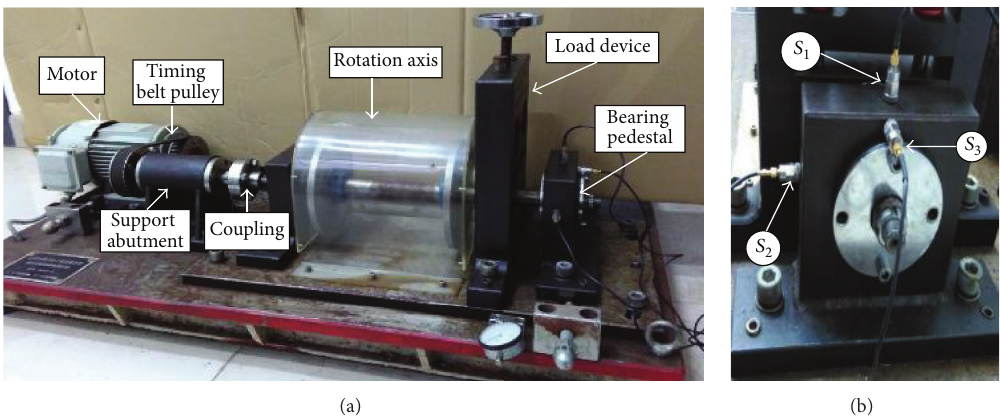
Figure 4: Rotating machinery fault simulation platform of QPZ-II: (a) experiment platform; (b) sensors locations.